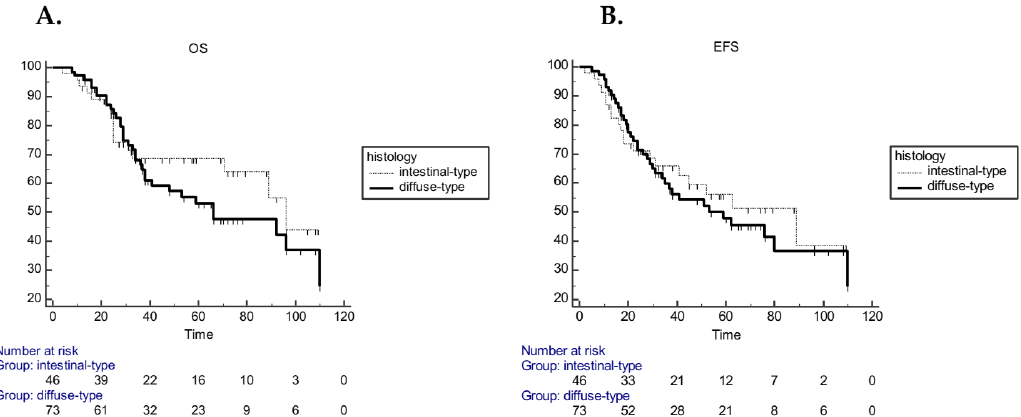
Figure 4. Kaplan–Meier curves for OS ( A ) and EFS ( B ) in aCT cohort according to histology (intestinal diffuse sub–type (HR 1.2; 95% CI 0.72–2.26; p = 0.40 for OS; HR 1.12 CI 95% 0.65–1.91; p = 0.67 for EFS).